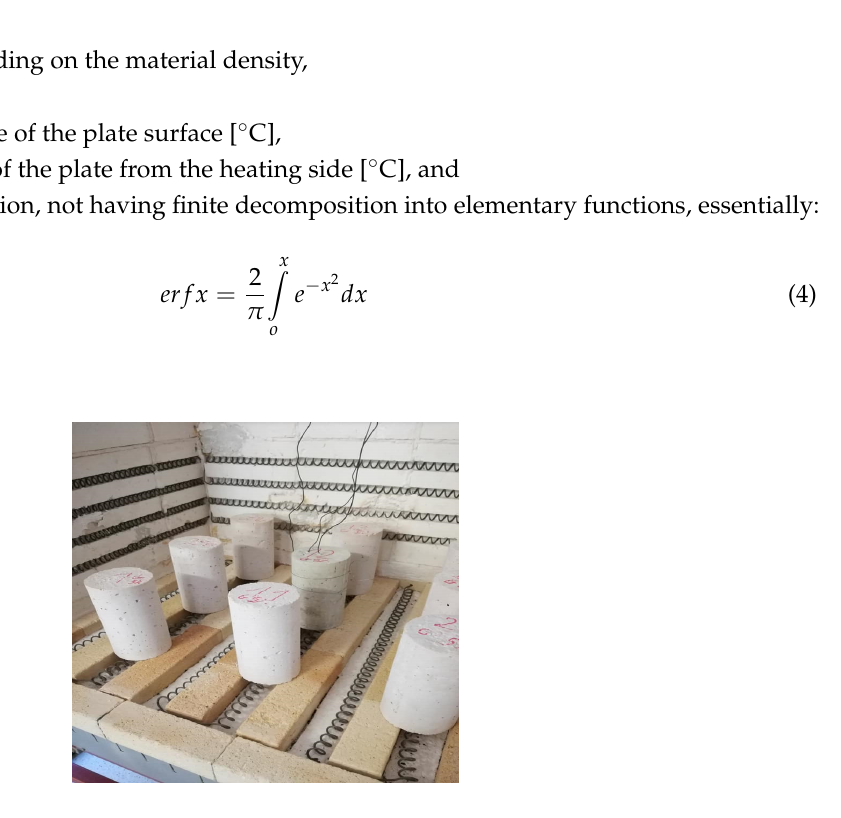
Figure 3. View of cylindrical samples before temperature loading, thermocouple fixing.